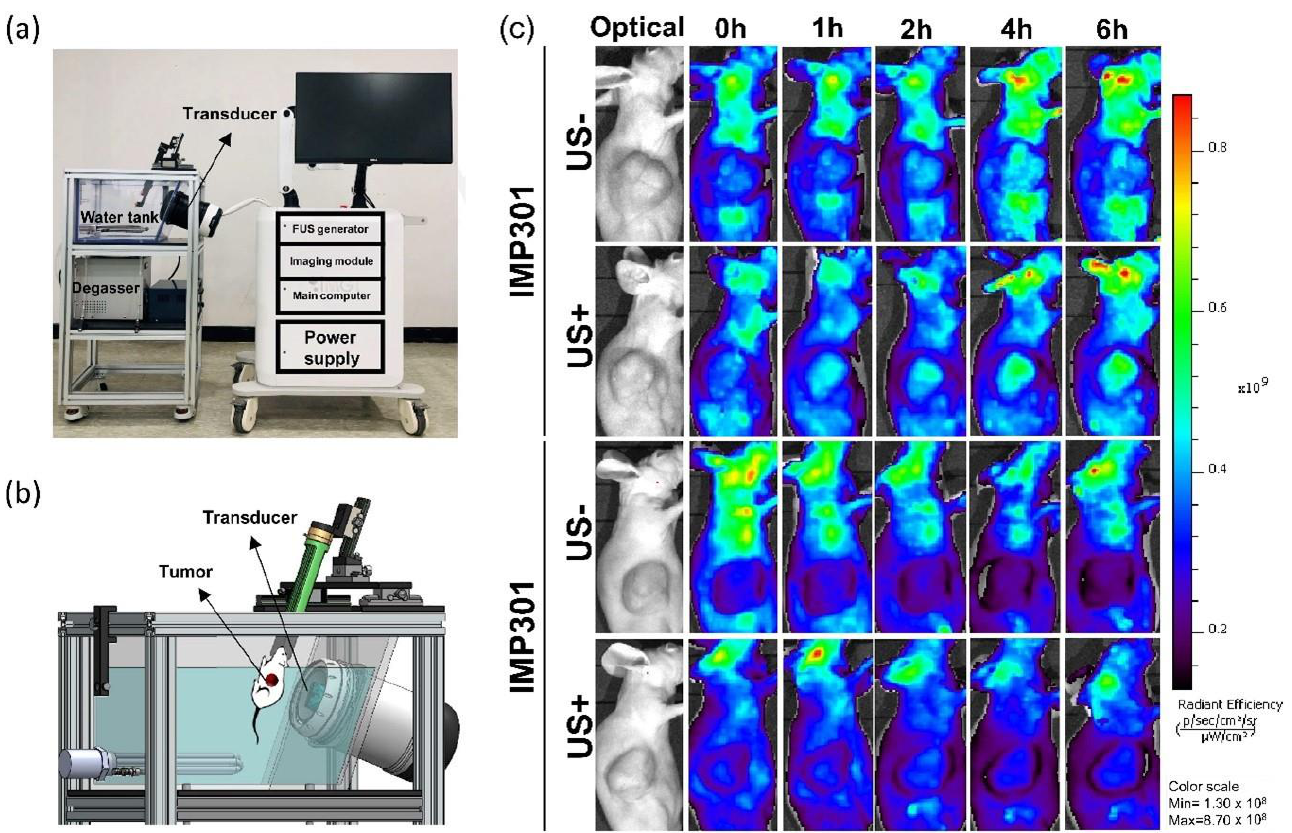
Figure 7. In vivo doxorubicin release from IMP301 and DOXIL under FUS irradiation using IMD- 10R. ( a ) System configuration of IMD-10R. ( b ) Schematic illustration of animal setting in water tank of IMD-10R. ( c ) The fluorescence intensity of doxorubicin was specifically detected using spectral unmixing at 408 – 460 nm excitation and emission for removal of autofluorescence after intravenous injection of DOXIL or IMP301 without or with FUS treatment.